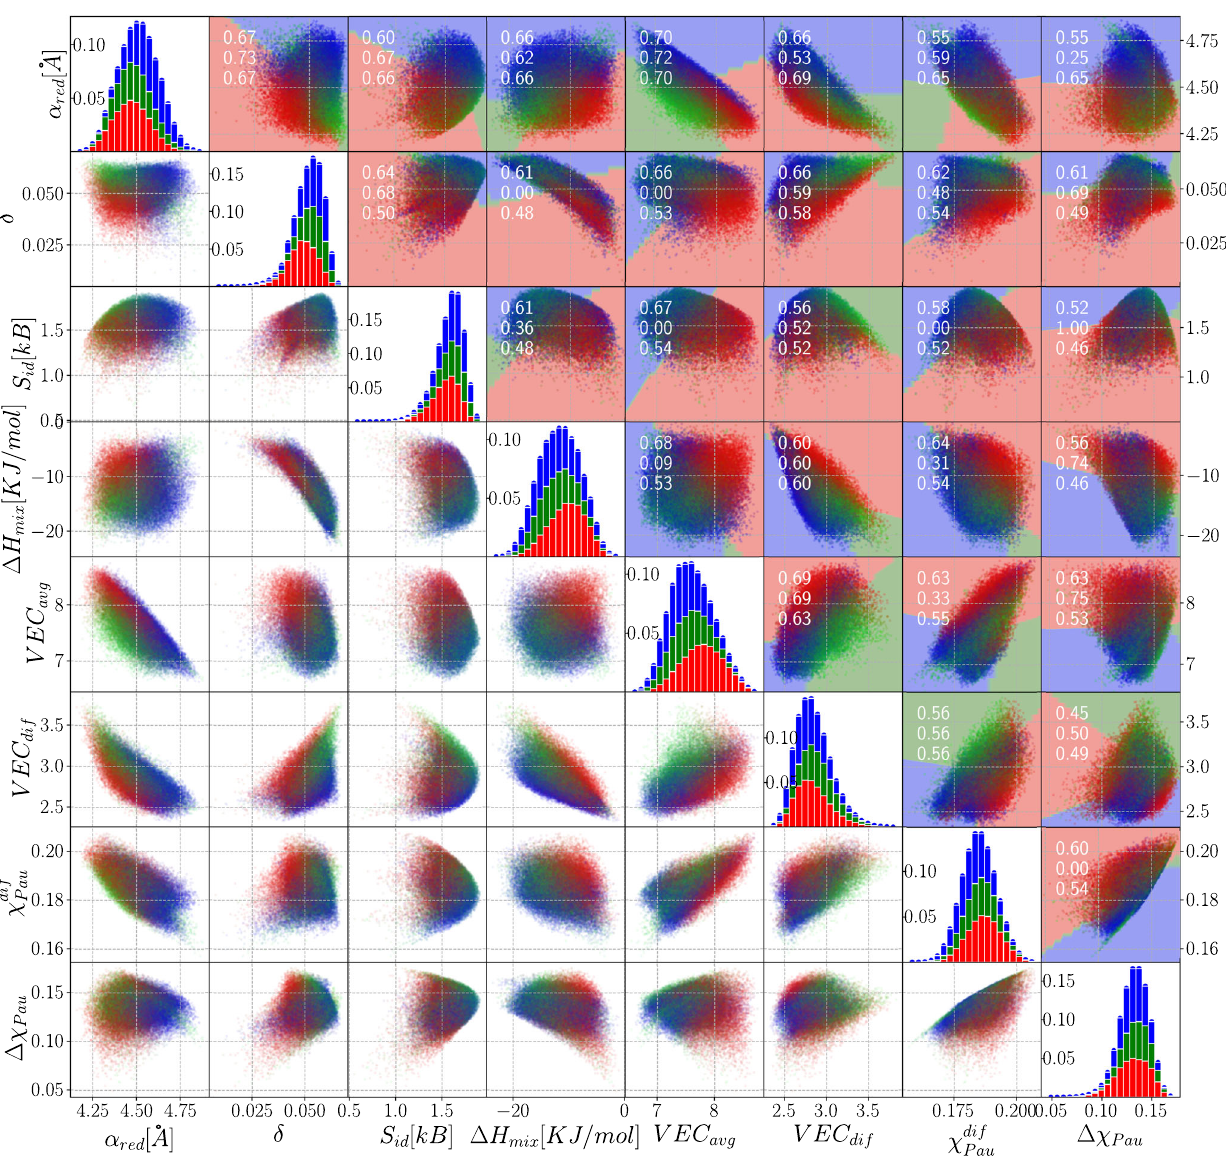
Fig. 7 Feature-pair analysis. Scatter plot of the phase composition where color is drawn in an RGB color value corresponding to [ FCC , BCC , Rest ]. At the right hand, l-SVC decision borders and classi fi cation precision for the three classes are